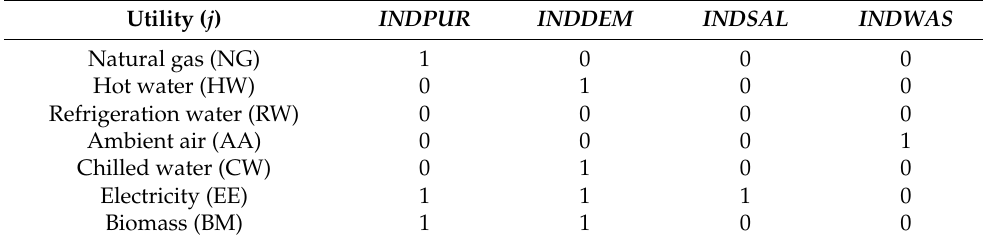
Table 3. System interaction